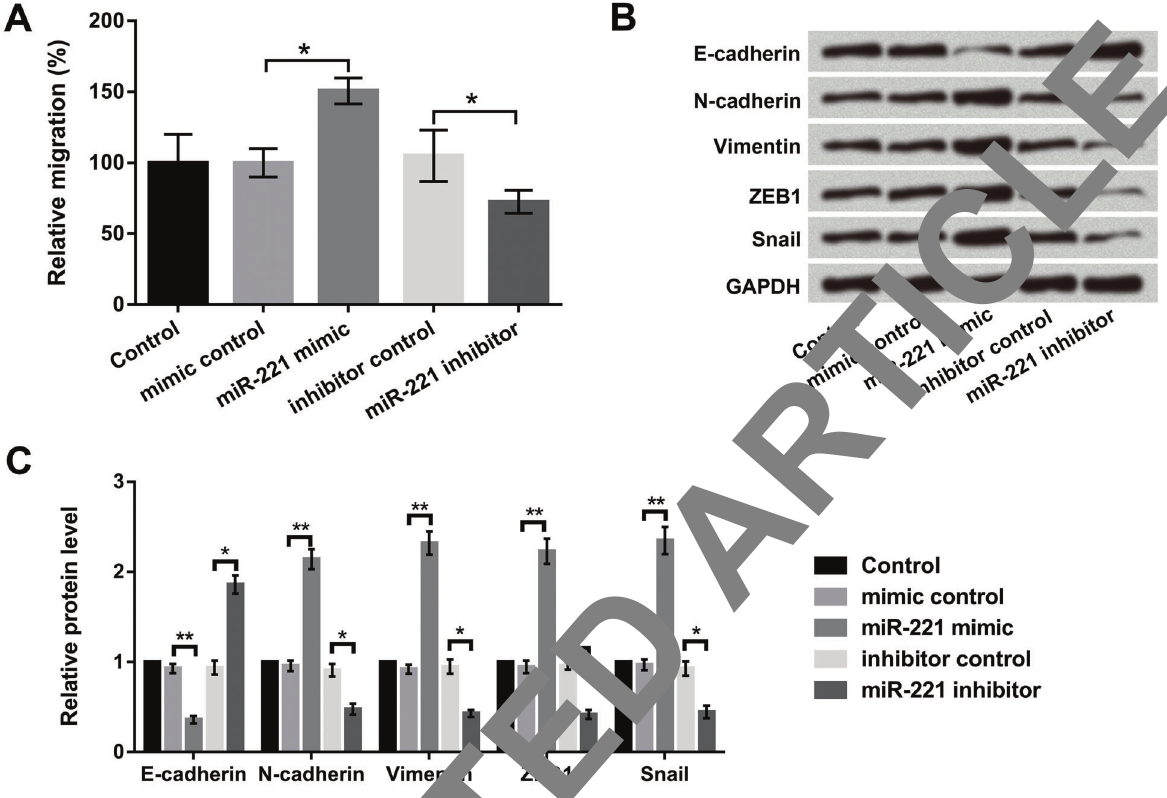
Figure 3. Overexpression of miR-221 promotes osteoblast migration. A , Cell migration was measured using the Transwell migration assay. B and C , Protein levels of EMT-related proteins (E-cadherin, N-cadherin, Vimentin, ZEB1, and Snail) were determined using western blot. miR-221: microRNA-221; EMT: epithelial-mesenchymal transition. Data are reported as means ± SD. *P o 0.05, **P o 0.01